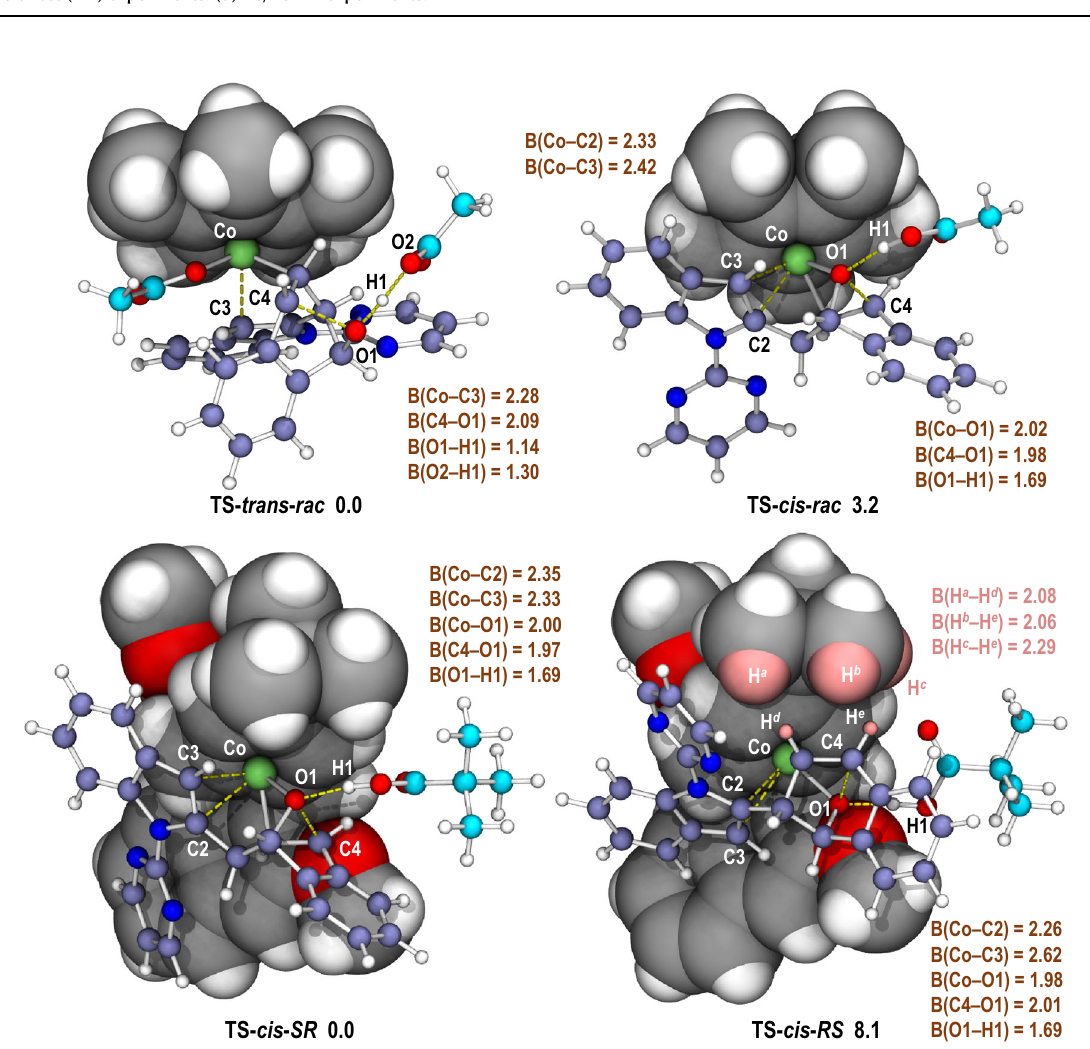
Fig.5|Optimizedstructuresofthetransitionstatesforthe β -oxygeneliminationstep. CalculatedatthePWPB95-D3(BJ)/def2-TZVPP(SMD,TFE)//B3LYP-D3(BJ)/def2- SVP (gas) level of theory. The relative Gibbs free energies ( Δ G sol ) are in kcal/mol. The distances of forming/cleaving bonds are in Å.